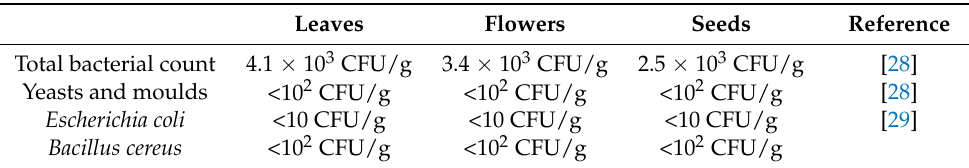
Table 3. Microbial counts of SO seeds, leaves, and